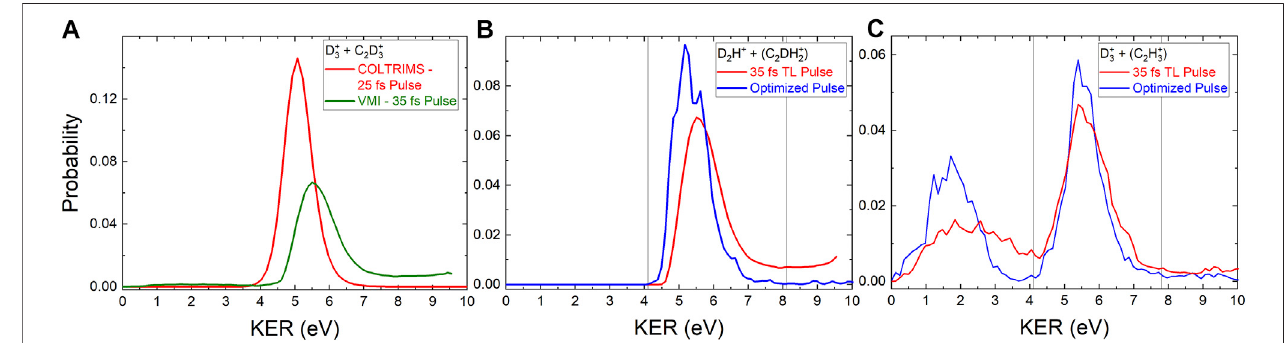
FIGURE 2 | (A) The red line shows the probability for two-body D + 3 + C 2 D + 3 fragmentation as a function of kinetic energy release (KER) measured with COLTRIMS. To compare the COLTRIMS and VMI measurements, we added the D 2 H + and D + 3 ions measured with VMI in a 7:1 ratio and plotted the combined probability for dissociation as a function of KER (olive line). (B) The VMI-derived KER distribution for D 2 H + ions assuming two-body breakup of D 3 C-CH 3 into D 2 H + + C 2 DH + 2 . The red linerepresentstheKERdistributionproducedbythetransformlimited(TL)pulse.ThebluelineistheKERdistributionproducedbytheoptimizedpulse.Thepeakof the KER distribution from the optimized pulse is 0.3 eV lower than the peak of the KER distribution from the TL pulse. (C) The KER distributions for the D + 3 channel assuming two-body breakup into D +